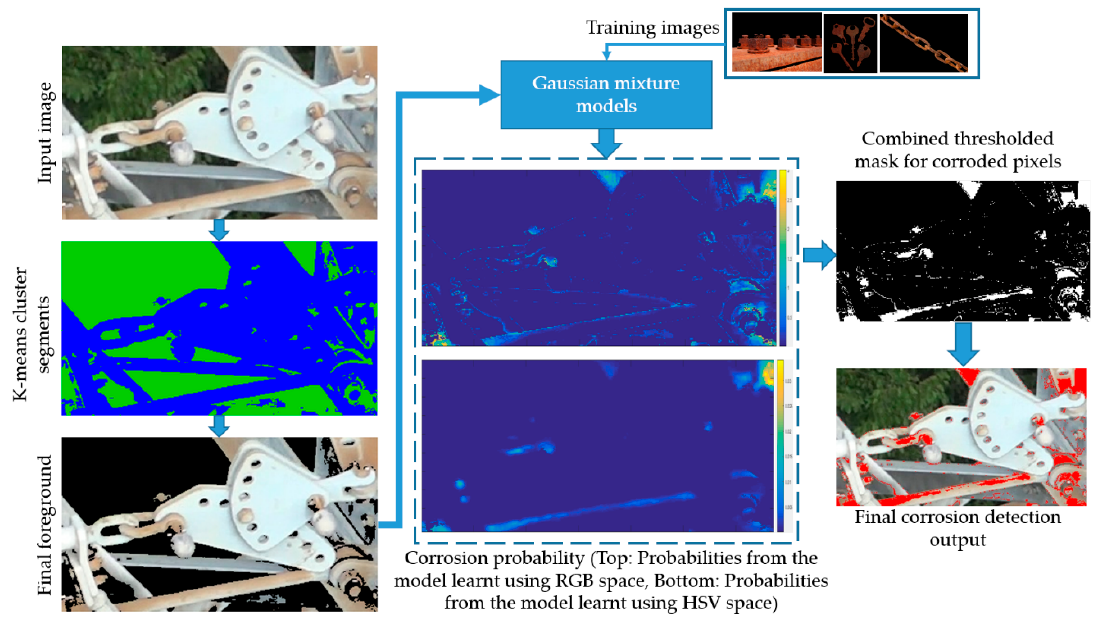
Figure 8. Schematic of the corrosion detection algorithm.